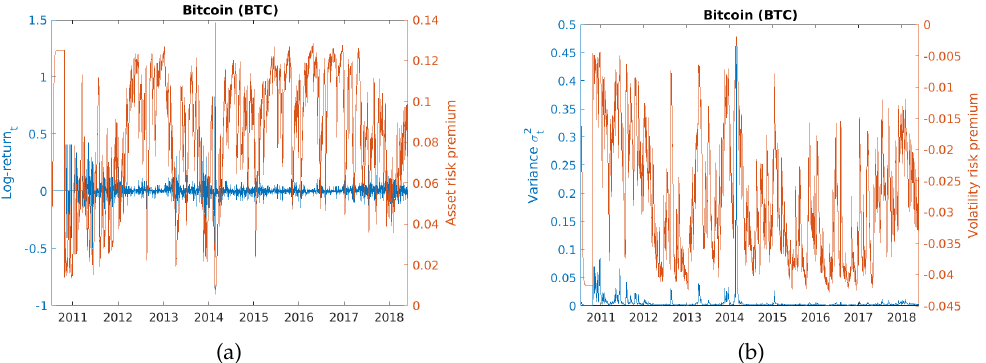
Figure 2. ( a ): Bitcoin returns and the asset risk premium. ( b ): Bitcoin variance and the volatility risk premium.